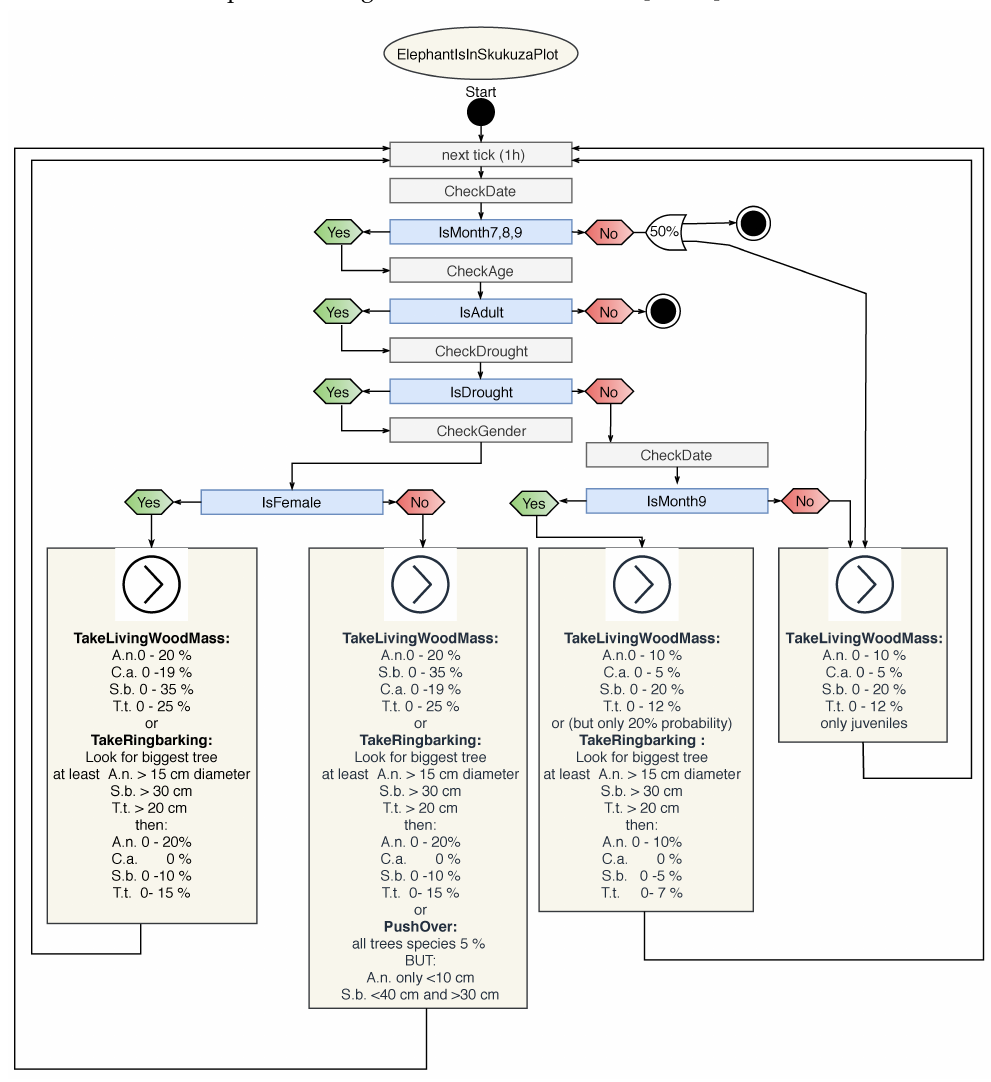
Figure A5. Elephant hourly tick routine in the SKU